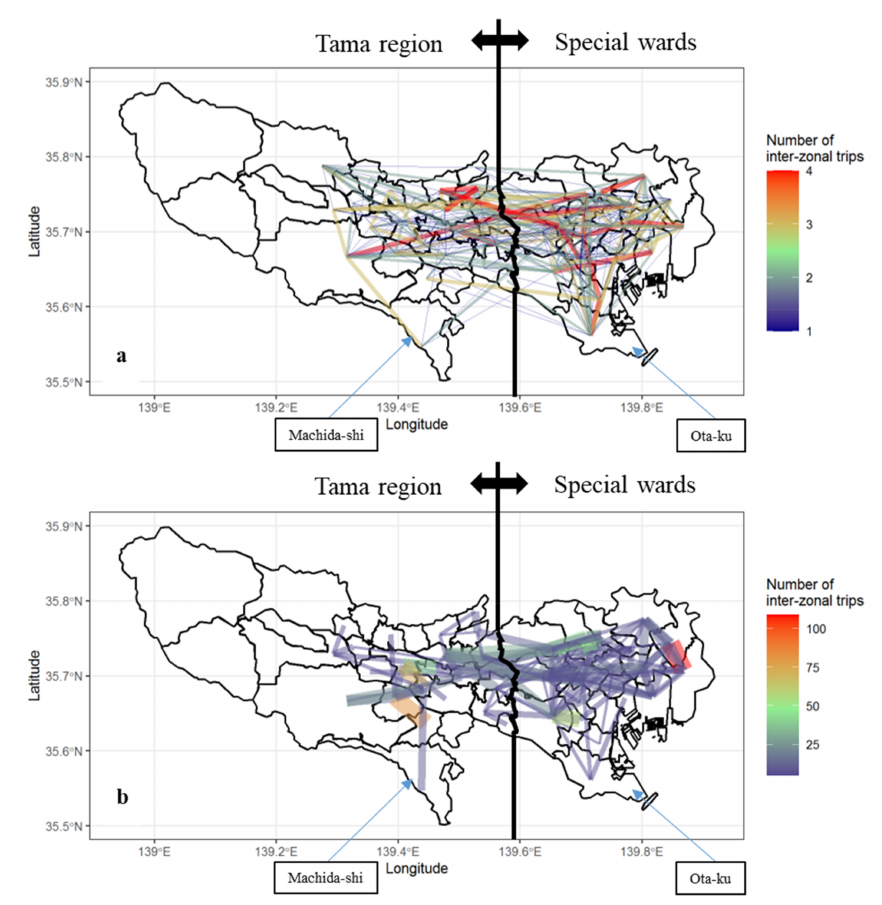
Figure 6. Spatial distribution of interzonal criminal trips: ( a ) OD pairs with fewer than five interzonal trips; ( b ) OD pairs with five or more interzonal